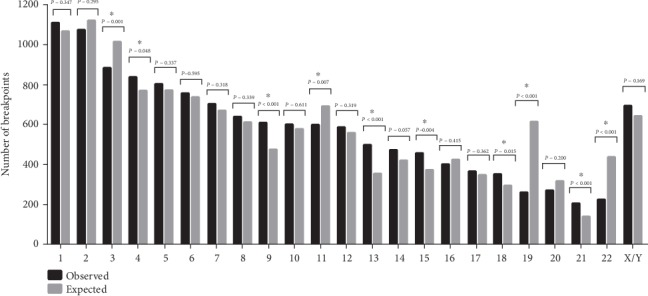
Comparison of chromosome integration distribution between observed and expected values.